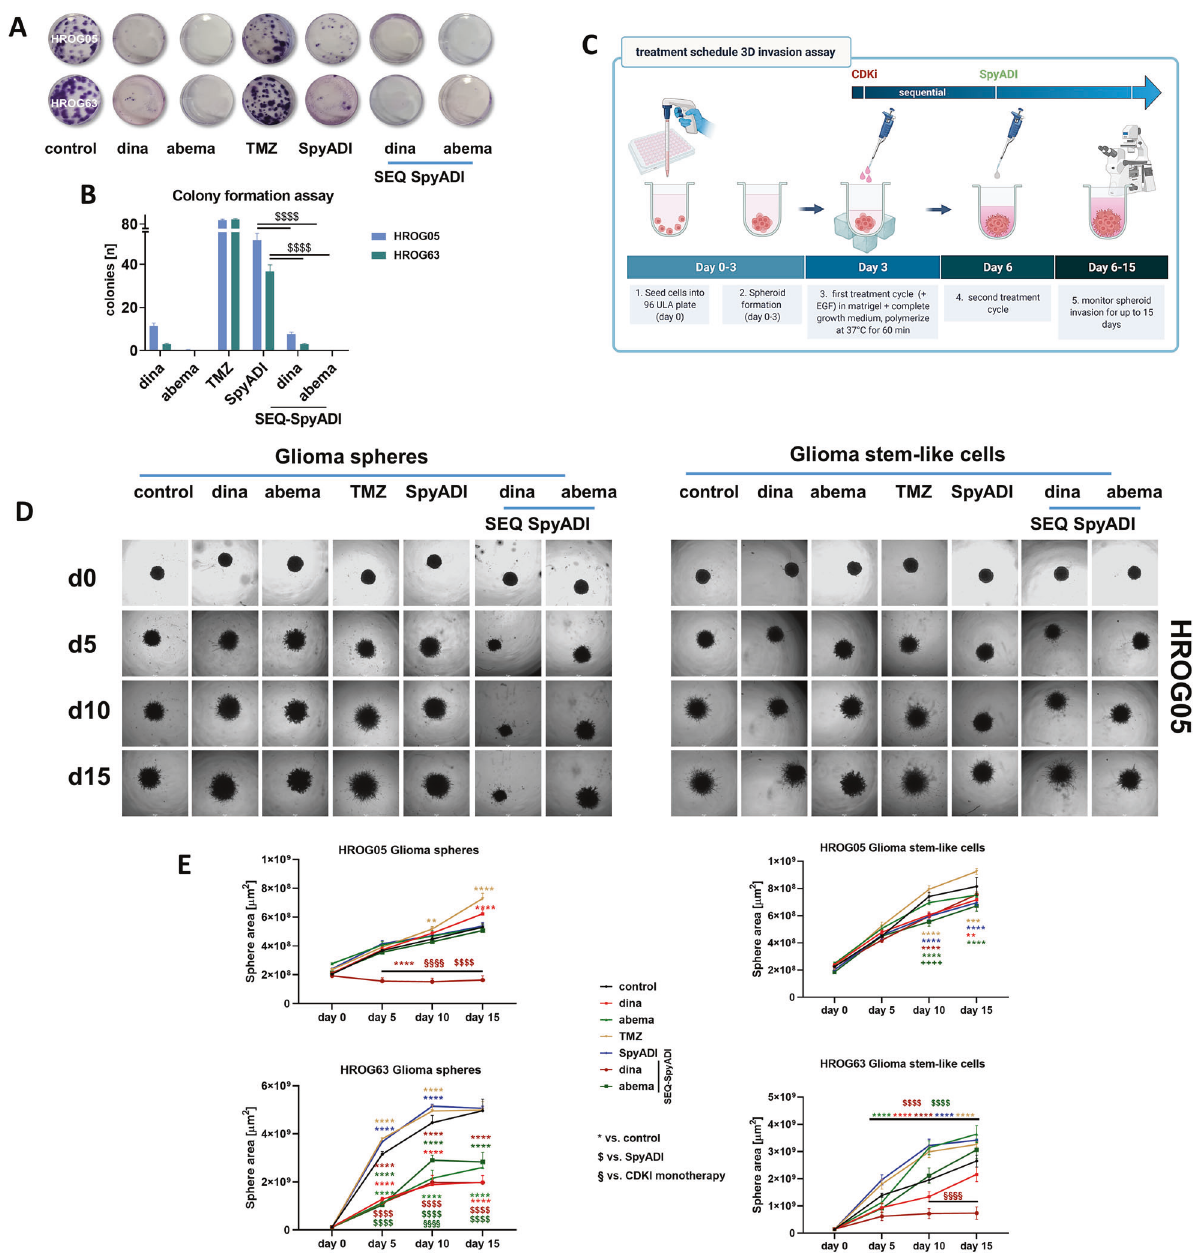
treatment ( = recovery). Biomass was quanti fi ed upon staining with 0.2% crystal violet and images were taken with a Leica DMI 4000B. A Representative light microscopic images. B Quanti fi cation of biomass ( = cell colonies) using ImageJ software (colony count of treated